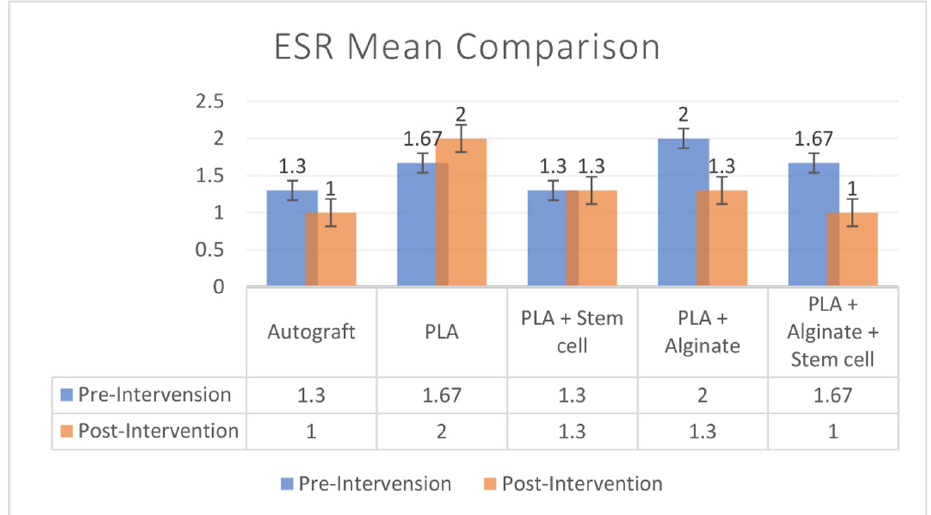
Figure 2. Pre-operative and post-operative ESR comparison among groups. Figure 2 . Pre-operative and post-operative ESR comparison among groups.